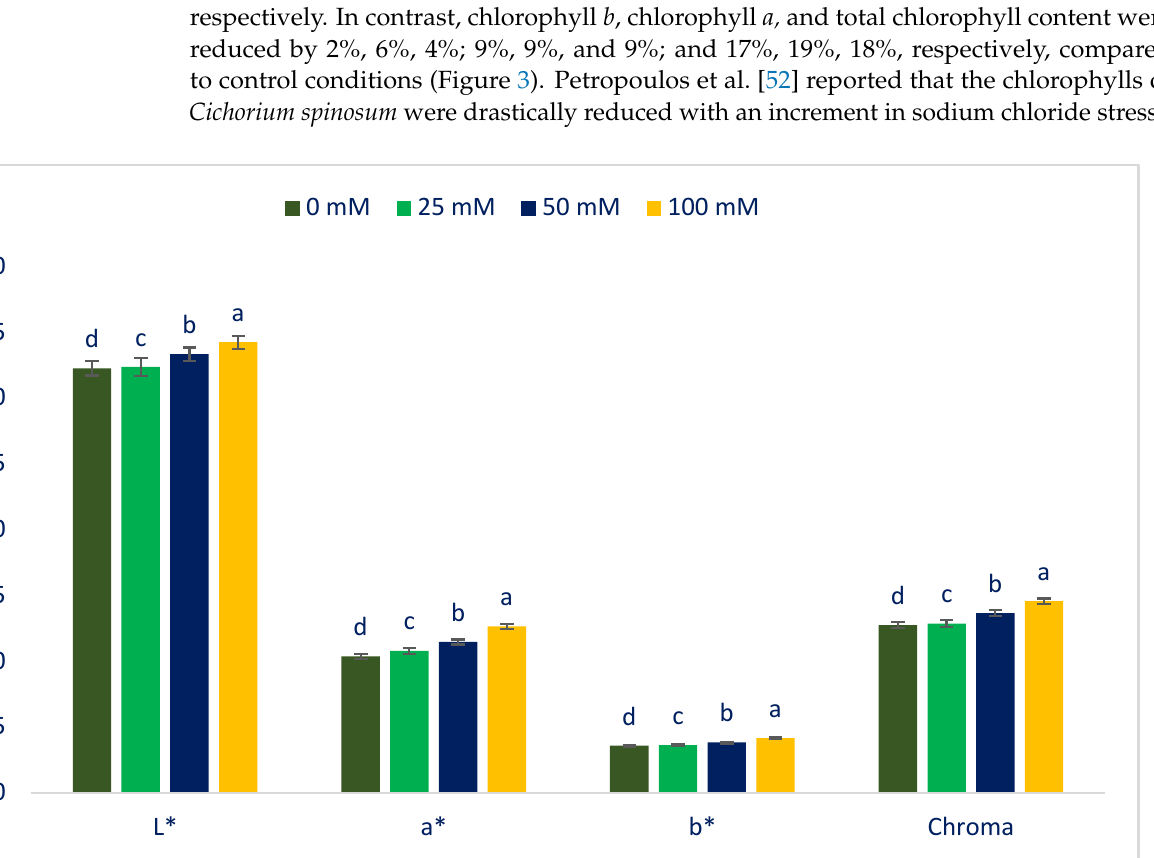
Figure 1. Color attributes of Lalshak as influenced by salt stress ( n = 6). L* = Lightness; a* = Redness/greenness; b* = Yellowness/blueness. Dissimilar letters in the bars varied significantly by Duncan’s Multiple Range Test (DMRT) ( p < 0.01).